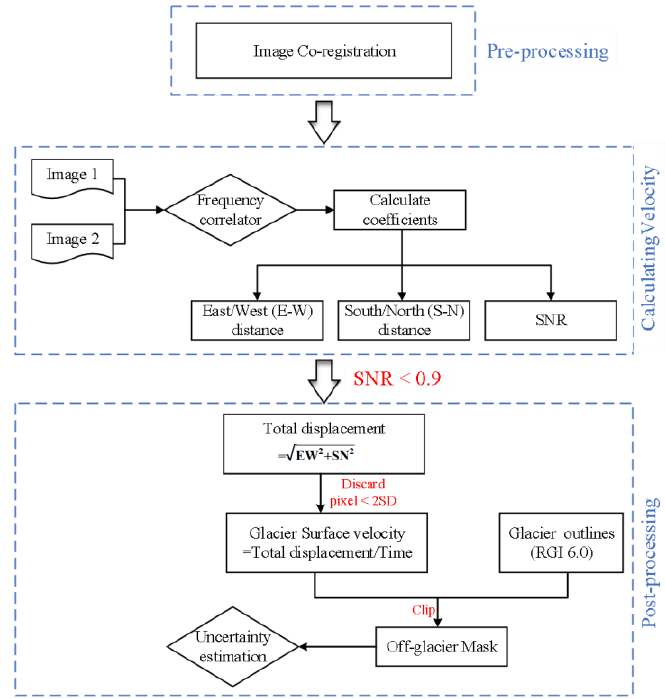
Figure 2. Overview of the research methodology.